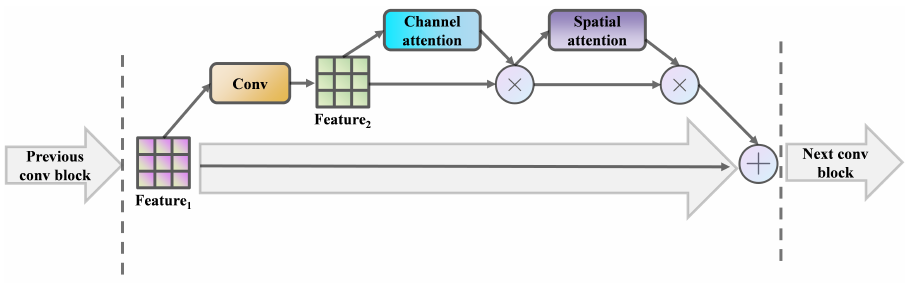
Figure 5. Attention module integrated with RBU in ResNet.